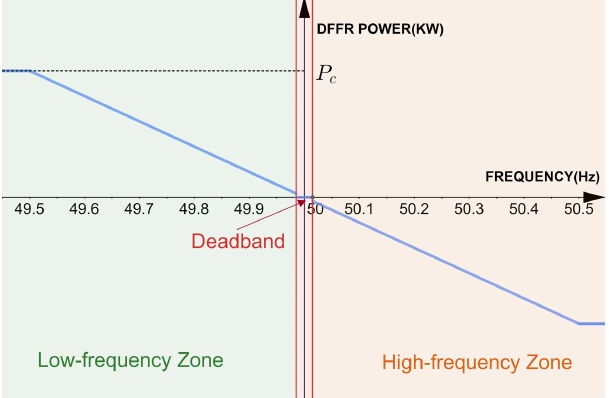
Figure 2. DFFR droop curve for a provider (blue